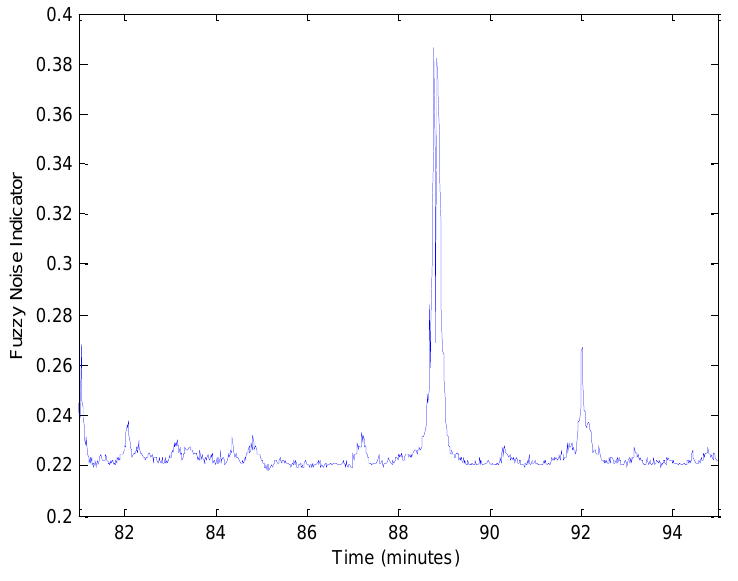
Figure 12. FNI for the noise data collection shown in Figure